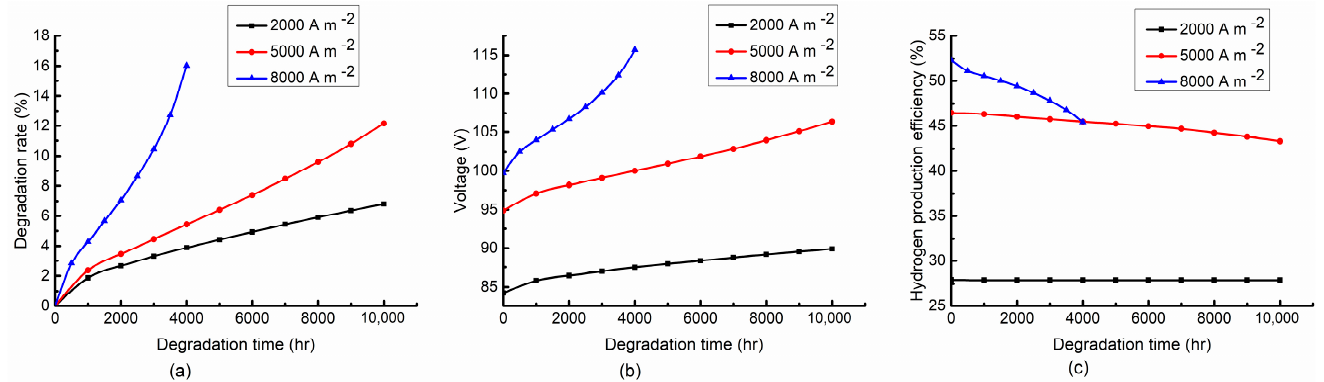
Figure 6. Variation trends of ( a ) degradation rate, ( b ) stack voltage and ( c ) hydrogen production efficiency with degradation time at 2000 A/m 2 , 5000 A/m 2 and 8000 A/m 2 . (Operating at 750 ◦ C and air − to − fuel feed ratio of